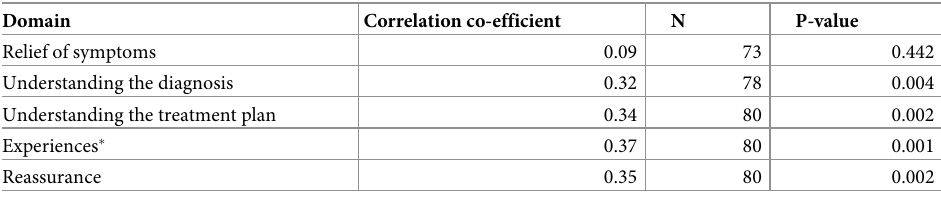
Table 3. Correlation between overall satisfaction and individual